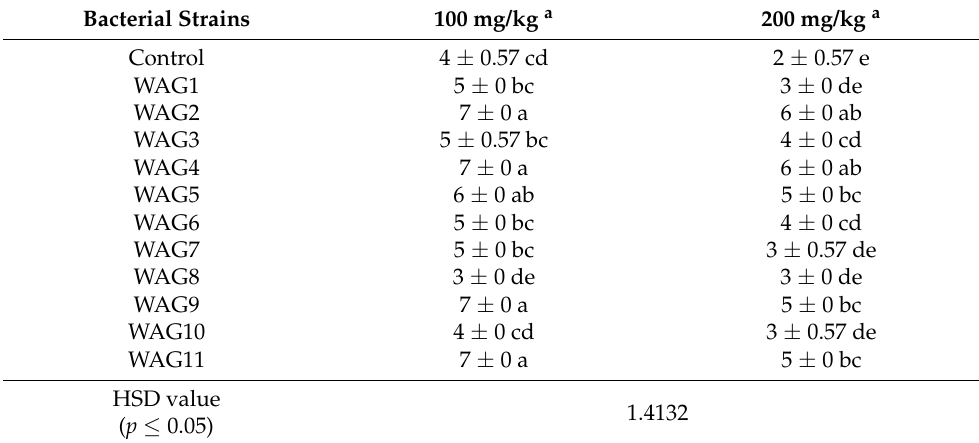
a Results represent the mean value ± standard deviation of three replications. Treatment means sharing same letter(s) within the column are statistically non-significant according to Tukey’s HSD test at p ≤ 0.05.